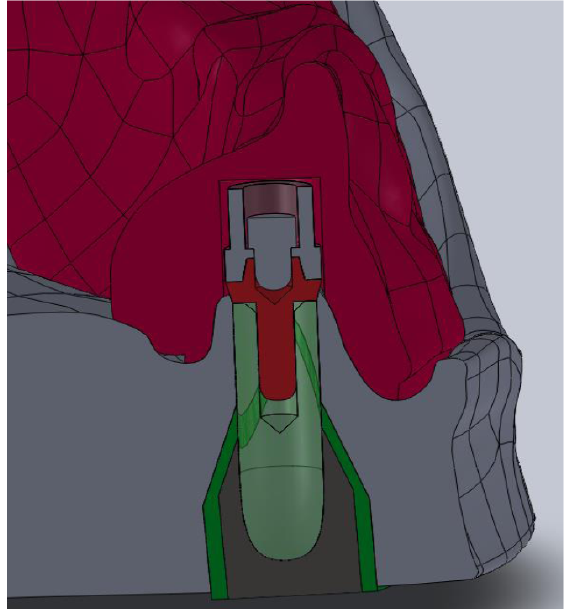
Figure 5. A cross-section showing the connection of system elements with bone.